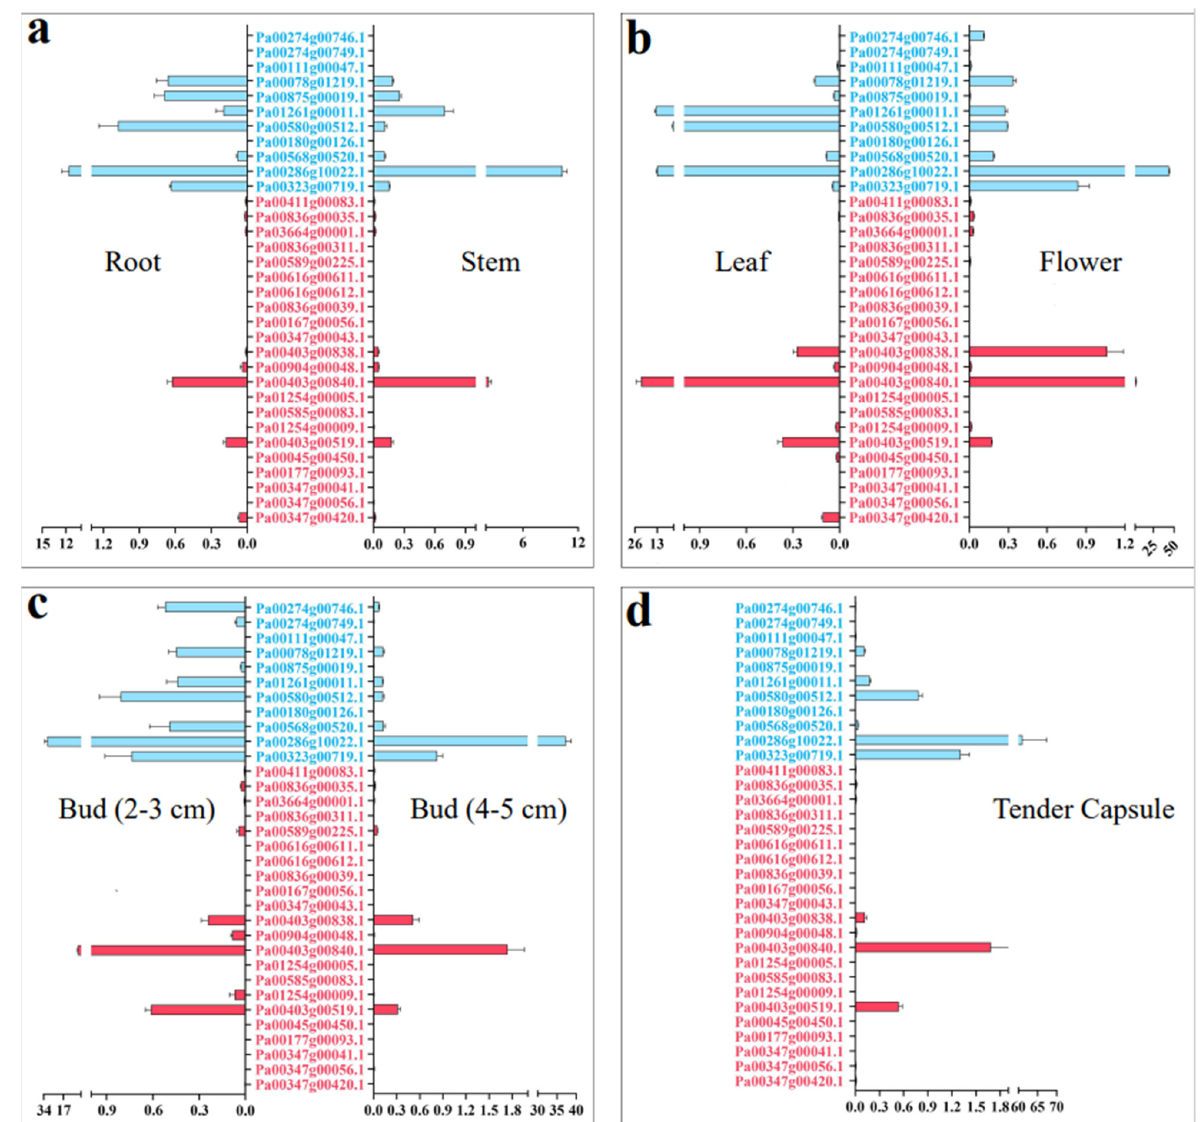
Figure 5. Relative expression of the CTLs family members in the different tissues of P. axillaris . ( a ) Expression pattern in root and stem. ( b ) Expression pattern in leaf and open flower. ( c ) Expression pattern in 2–3 cm and 4–5 cm flower. ( d ) Expression pattern in tender capsule tissues. The genes marked in blue were the members of the GH19 subgroup, and the genes marked in red were the members of the GH18 subgroup.